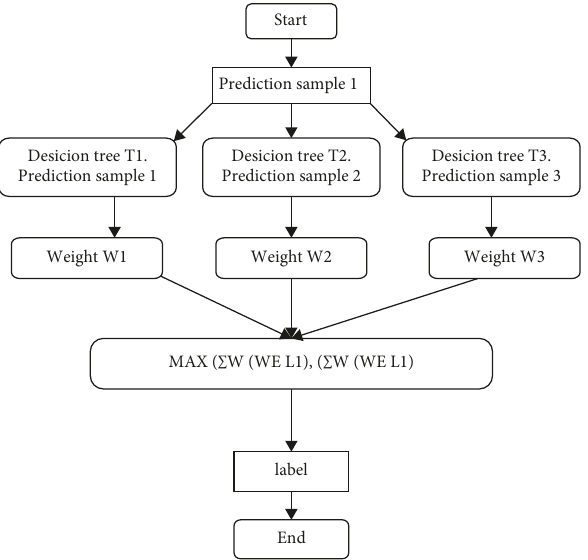
Figure 3: Parallel voting flowchart of weighted random